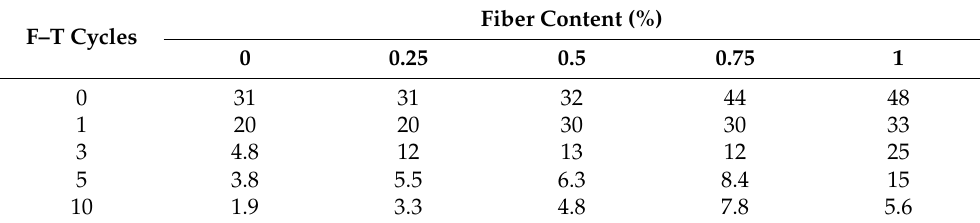
Table 2. Elastic modulus of the FCMS obtained in F–T cycles